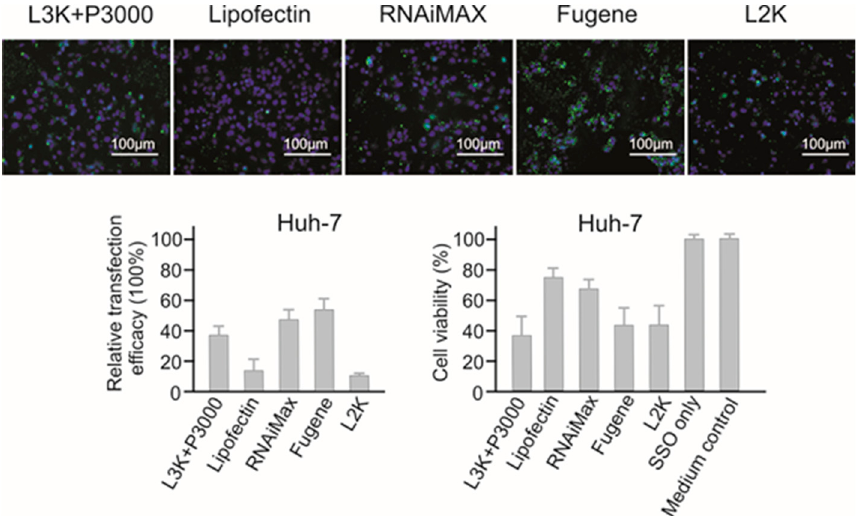
Figure 3. In vitro transfection efficiency and cytotoxicity of different transfection reagents in Huh-7 cells. L3K: Lipofectamine 3000, L2K: Lipofectamine 2000.